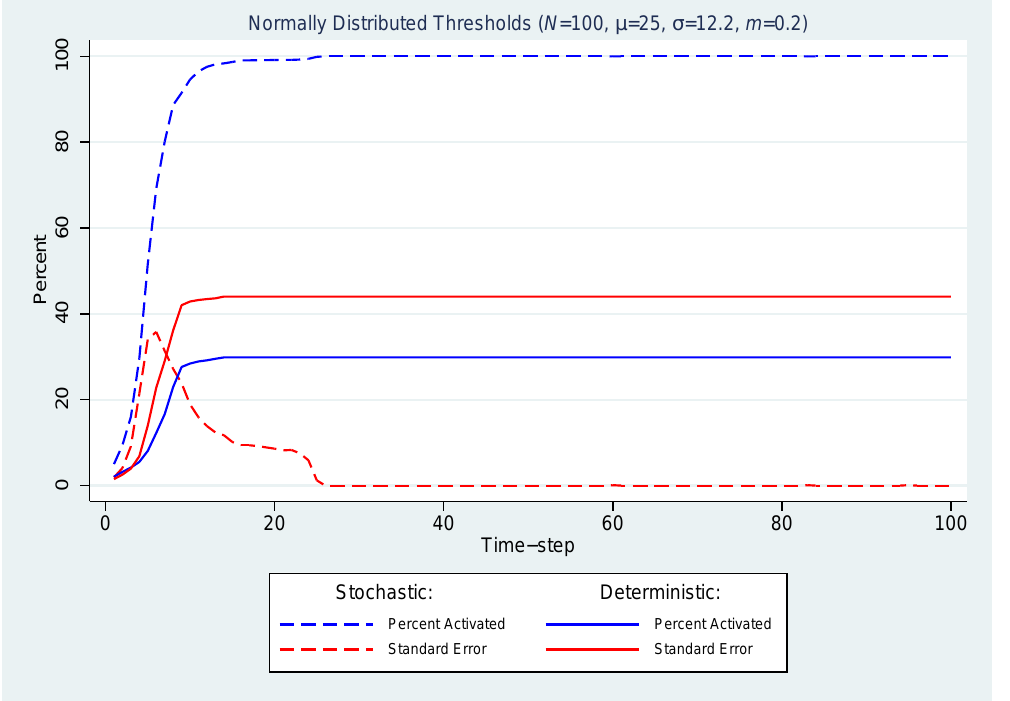
Figure 3: Unpredictability of activation level with a normal threshold distribution ( N = 100, µ = 25, σ = 12.2). Unpredictability is measured as the observed standard error of the mean percentage activated over 100 random samples from a normal distribution of thresholds. With deterministic thresholds, cascades reach an average of 25 percent activated with a standard error of 42 percent. With stochastic thresholds ( m = 0.2), cascades are not trapped by perturbations in the distribution. The standard error first increases slightly as the percentage activated increases over time but then decreases to zero as the activation level increases to 100 percent. With greater noise (e.g., m = 0.1, not shown), the standard error reaches zero in four time steps, and with less noise (e.g., m = 0.25), the standard error remains slightly above